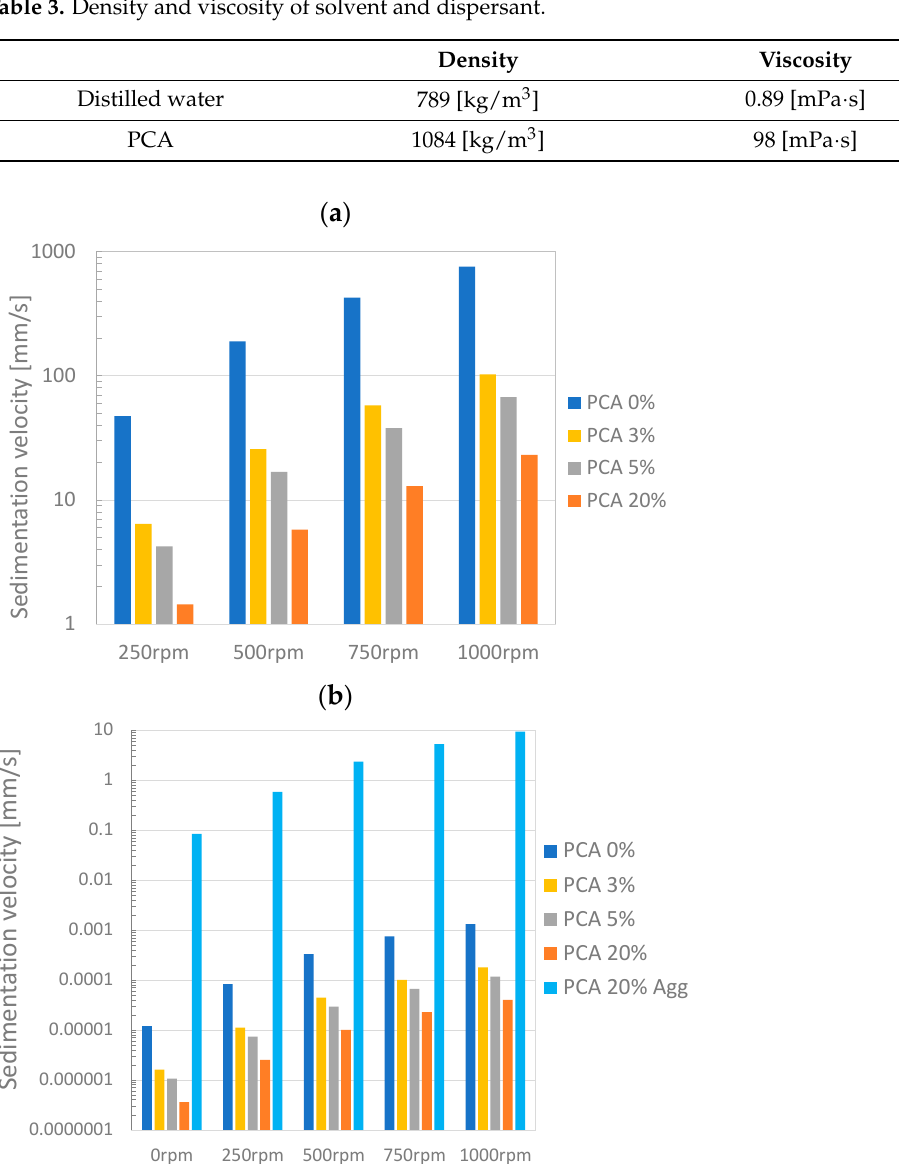
Figure 20. Simulated sedimentation velocity, ( a ) for SUS304, and ( b ) for ZrO2 (particles and aggre- gations).